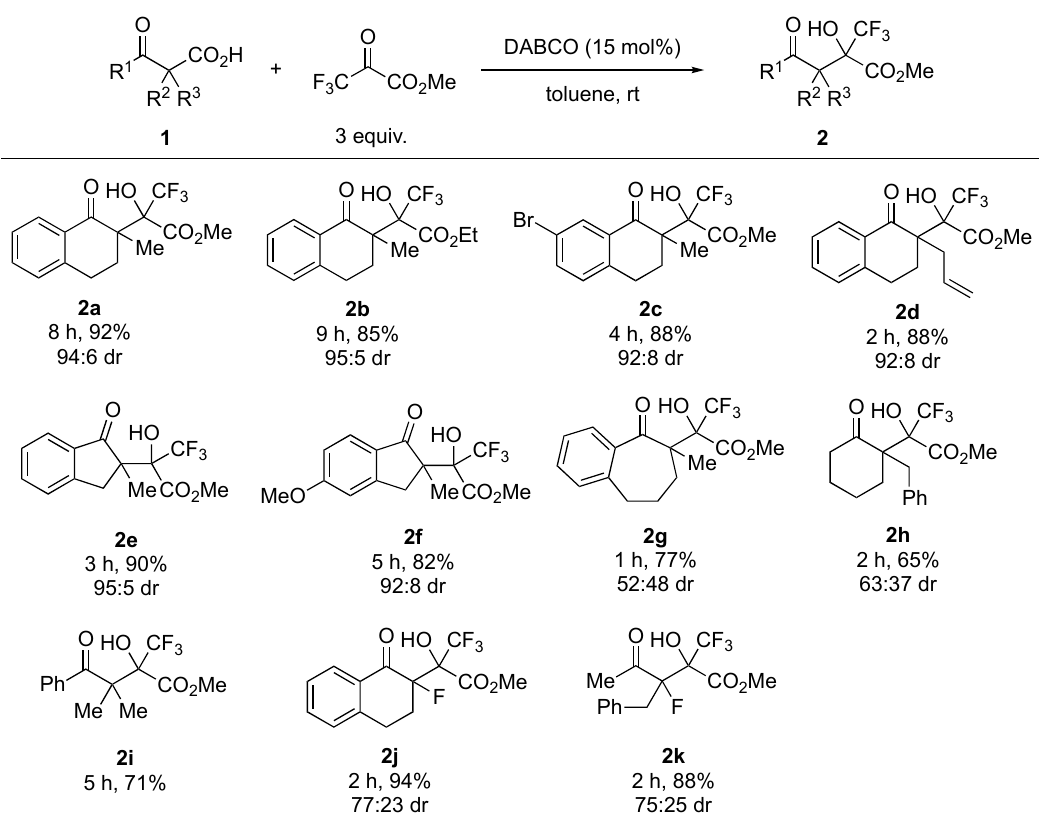
Figure 2. Substrate scope 1 . 1 All reactions were carried out at room temperature in toluene with 3 equiv. of trifluoropyruvates in the presence of 15 mol% DABCO. Isolated yields were described. Diastereomeric ratios were determined by 1 H-NMR analyses.